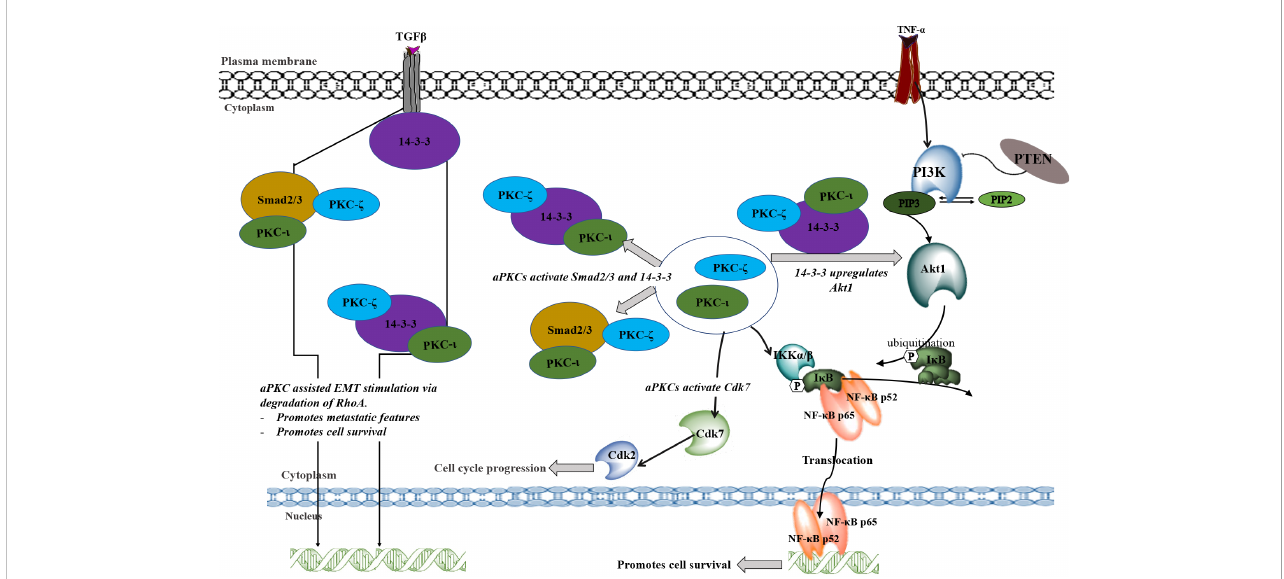
FIGURE 7 A schematic summary of the involvement of PKC- i and PKC- z in NB progression. TNF- a and TGF b may stimulate the aPKC activity which leads to associate with 14-3-3 and Smad2/3. These associations may upregulate key signaling points to upregulate Akt1/NF- k B pathway and the EMT stimulation by inducing the loss of E-cadherin and gain of Vimentin. During EMT stimulation, activated Smad2/3 and 14-3-3 (through the phosphorylation of aPKCs) will destabilize RhoA and induce transcription factors to induce EMT. On the other hand, activated 14-3- induces Akt1 which leads to the inactivation of inhibitory action of PTEN on PIP3. This may result in activation of Akt1 through the activated 14-3-3 via aPKCs. Activated Akt1 pathway also activates NF- k B pathway in addition to direct upregulation of activated aPKCs. Akt1/NF- k B pathways lead to cell survival, rapid proliferation, and differentiation of NB cells. In addition, activated aPKCs upregulate Cdk7 which leads to the cell cycle progression of NB cells. In summary, this schematic diagram shows how aPKCs are crucial for NB progression with respect to multiple cellular